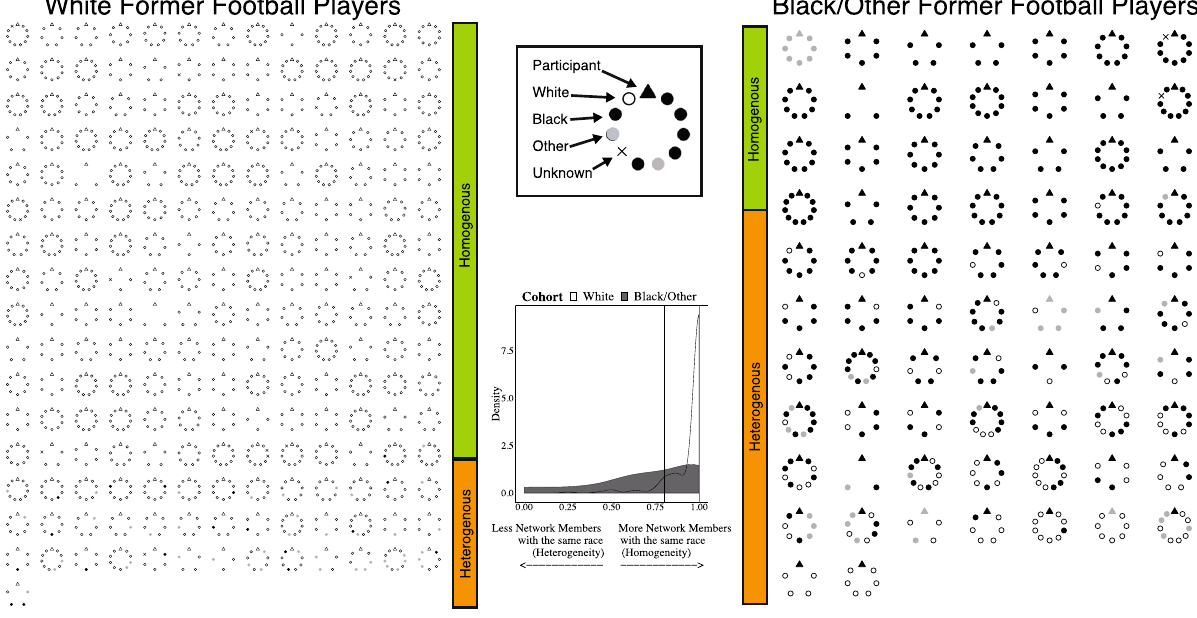
Figure 3. Racial makeup of networks in White versus Black/Other former football players. Networks are ordered by the degree to which networks have the same race as the respondent (top left, homogenous) to networks that have different race as the respondent (bottom right, heterogenous). A summary of the racial homogeneity versus heterogeneity distributions of the networks is visualized by the density graph. Participants with networks < 2 or entirely missing data are not included in the montages. Black/Other former football players are more likely than white former football players to have racially diverse